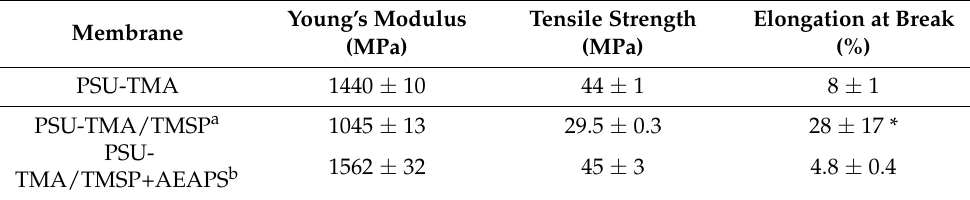
Table 1. Mechanical properties of membranes in Cl form at ambient humidity and